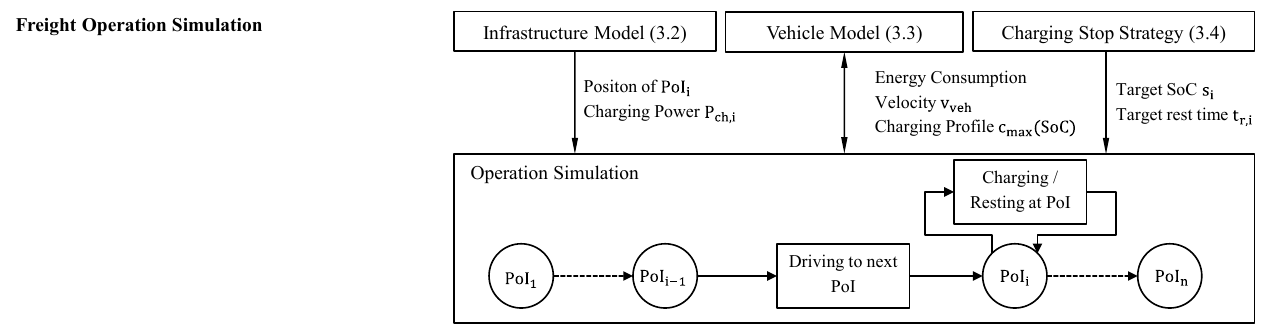
Figure 2. Freight operation simulation framework. The operation simulation is carried out in a PoI-based manner, using the infrastructure model for the PoI positioning, the vehicle model for the energy consumption, and the charging stop strategy for specification of the action at one PoI.